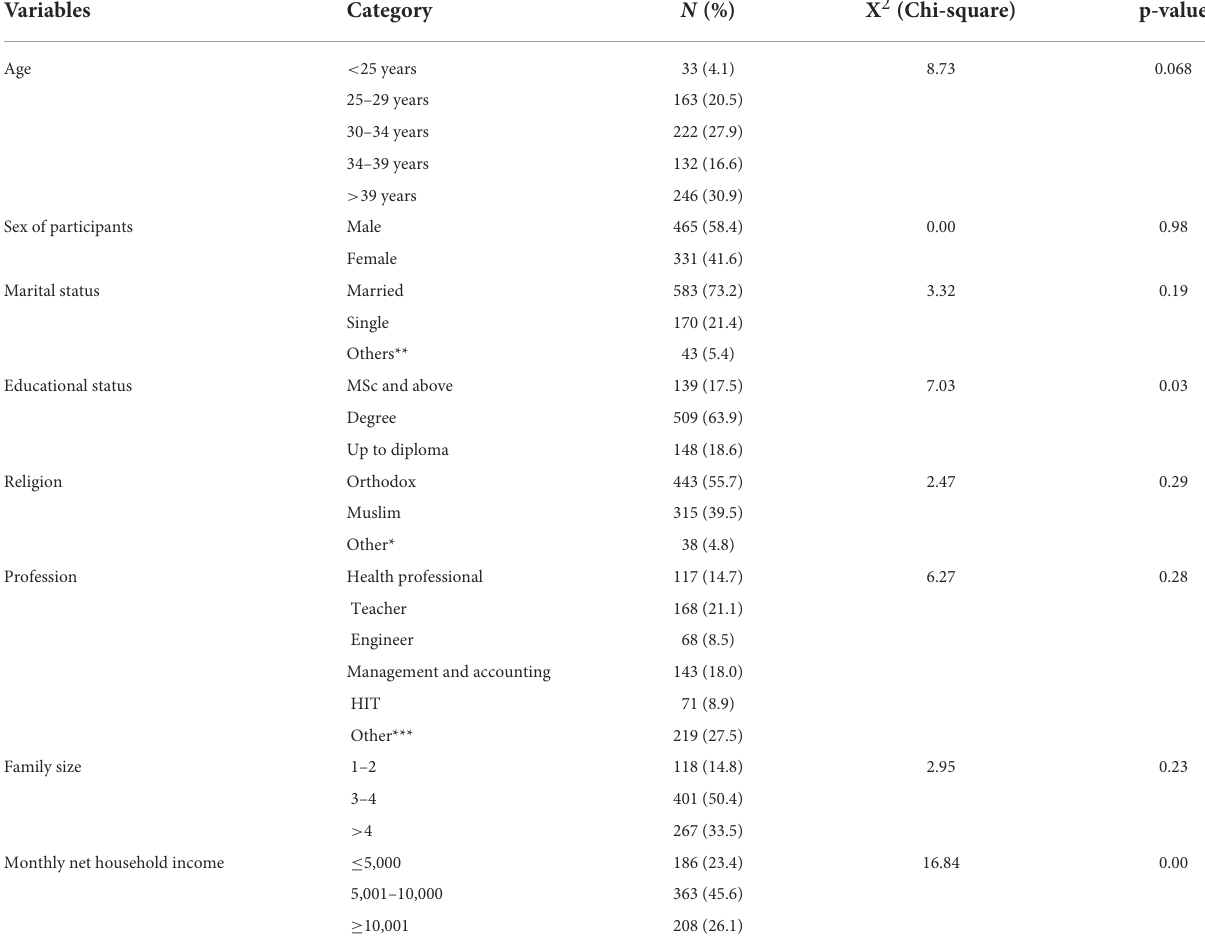
TABLE 3 Sociodemographic descriptions of public civil servants in DCA, North-East Ethiopia ( n = 796), May 2021. Variables